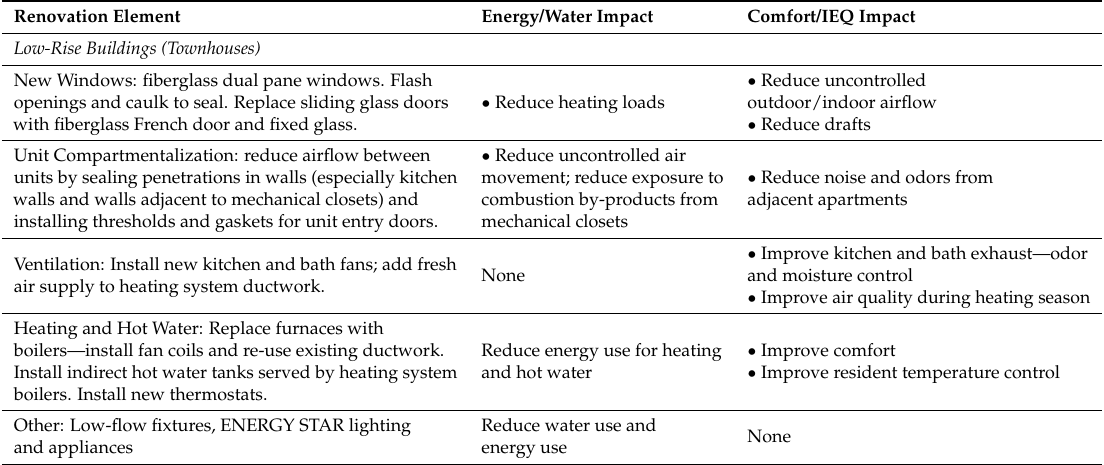
Table A1. Summary of energy-saving building renovations conducted in the low-rise (townhouse) buildings at Castle Square Apartments in Boston, Massachusetts.